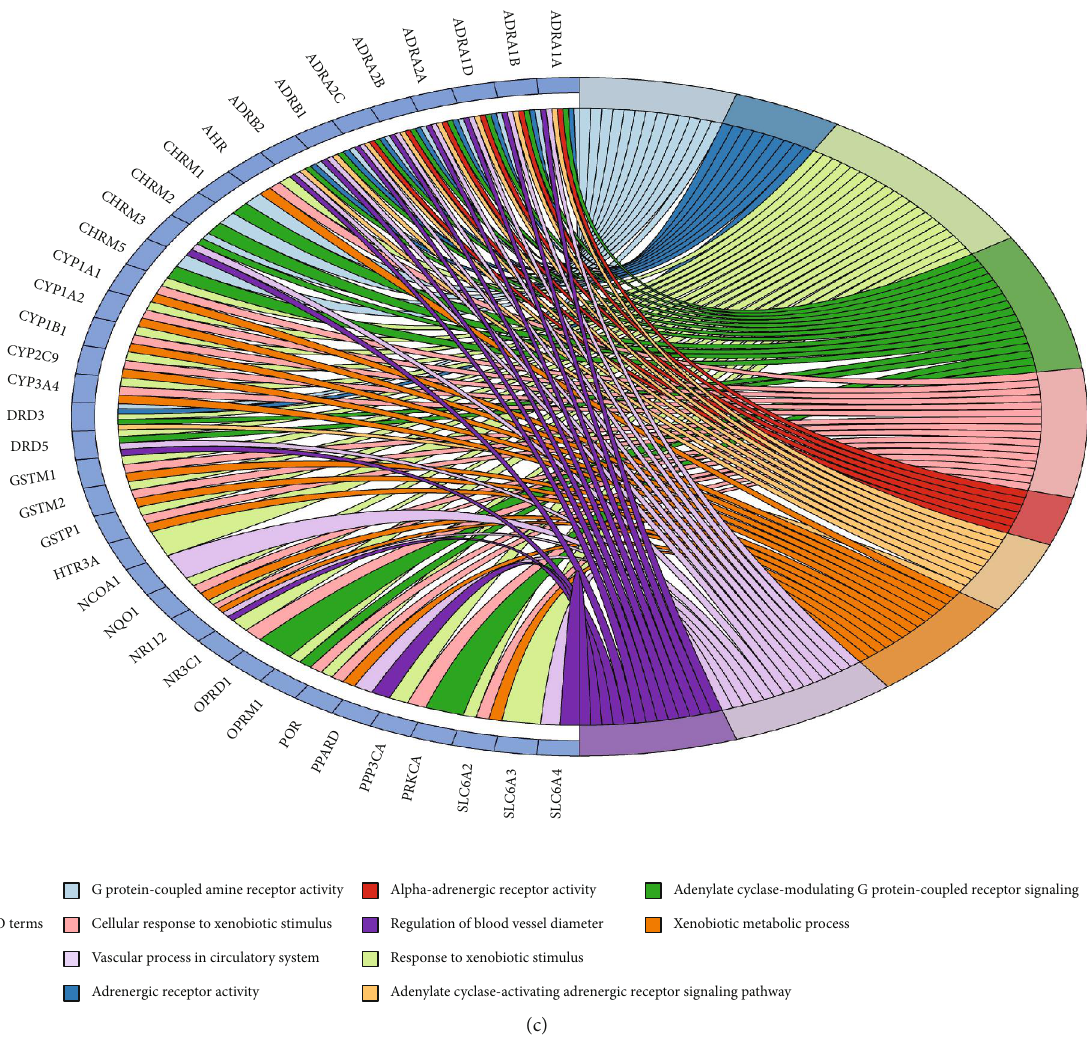
Figure 7: (a) GO biological process analysis of cluster 1. (b) GO biological process analysis of cluster 2. (c) GO biological process analysis of cluster